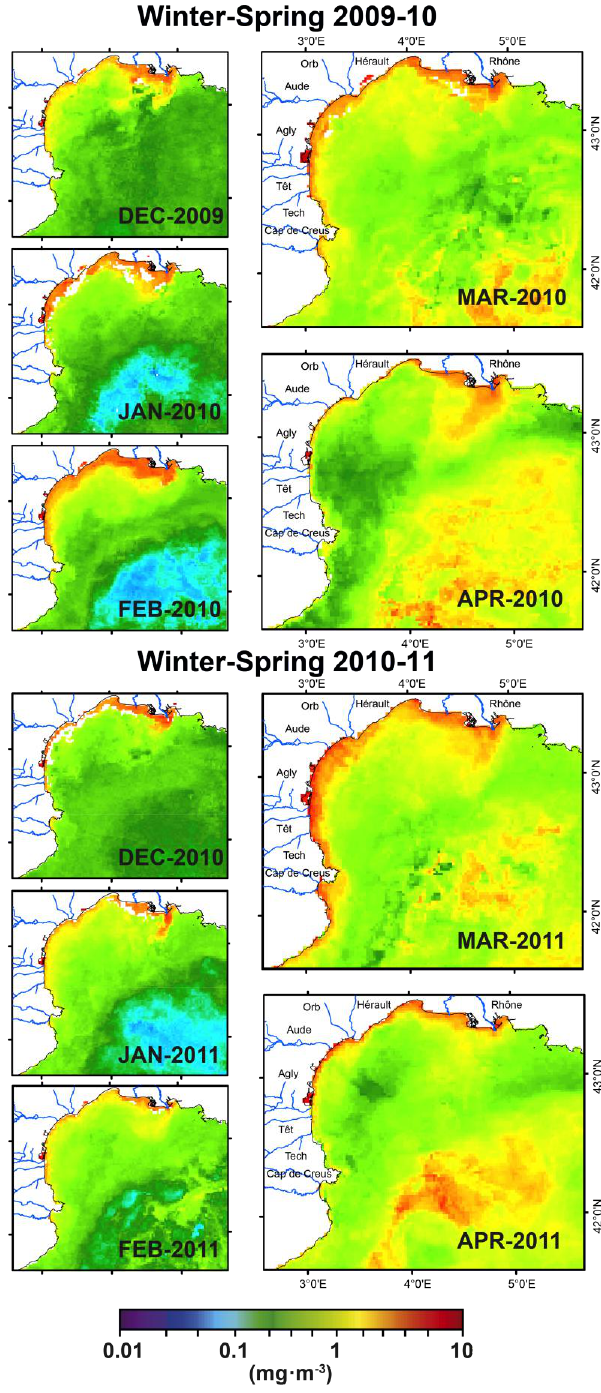
Fig. 4. Sequence of monthly mean Chlorophyll a concentration in the study area during both winter-spring periods.